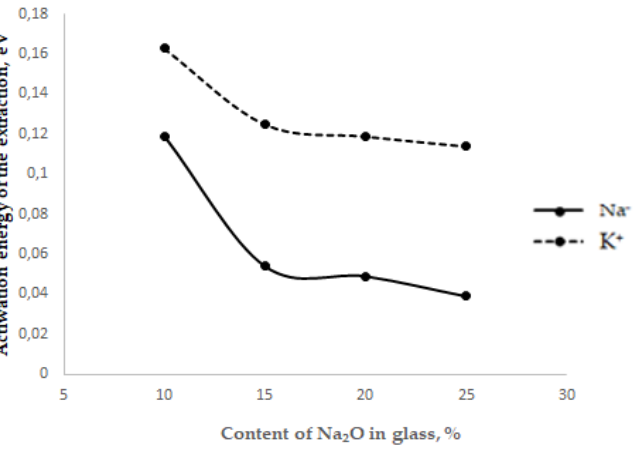
Figure 2. Dependence of the activation energy of the extraction process on the type and content of alkalis.